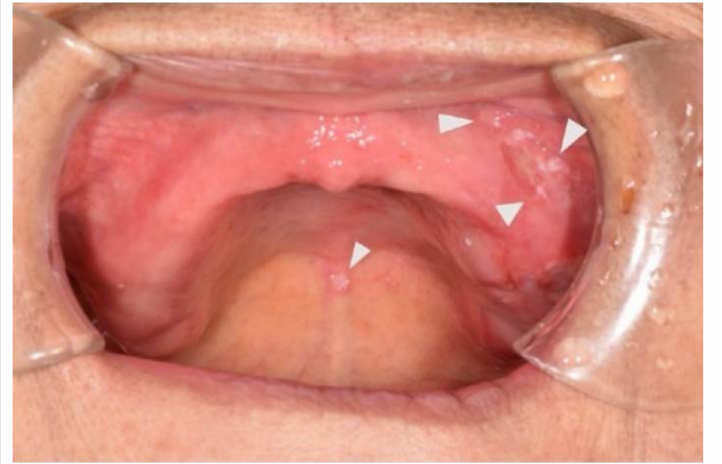
Figure 2. Oral findings 19 days after discharge. Ulcers in the oral cavity epithelialized and disap- peared. White tongue coating spreading into the oral cavity and a finding of oral